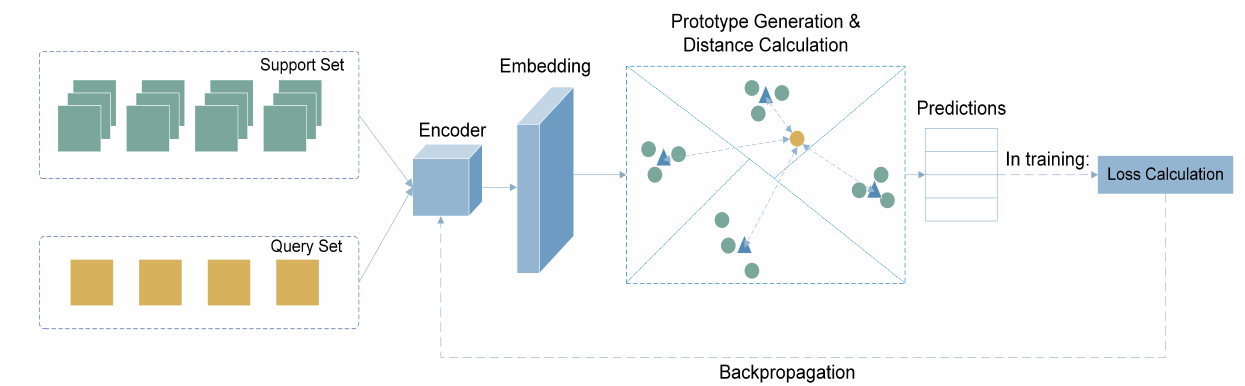
Figure 2. COVID-Net USPro, network architecture